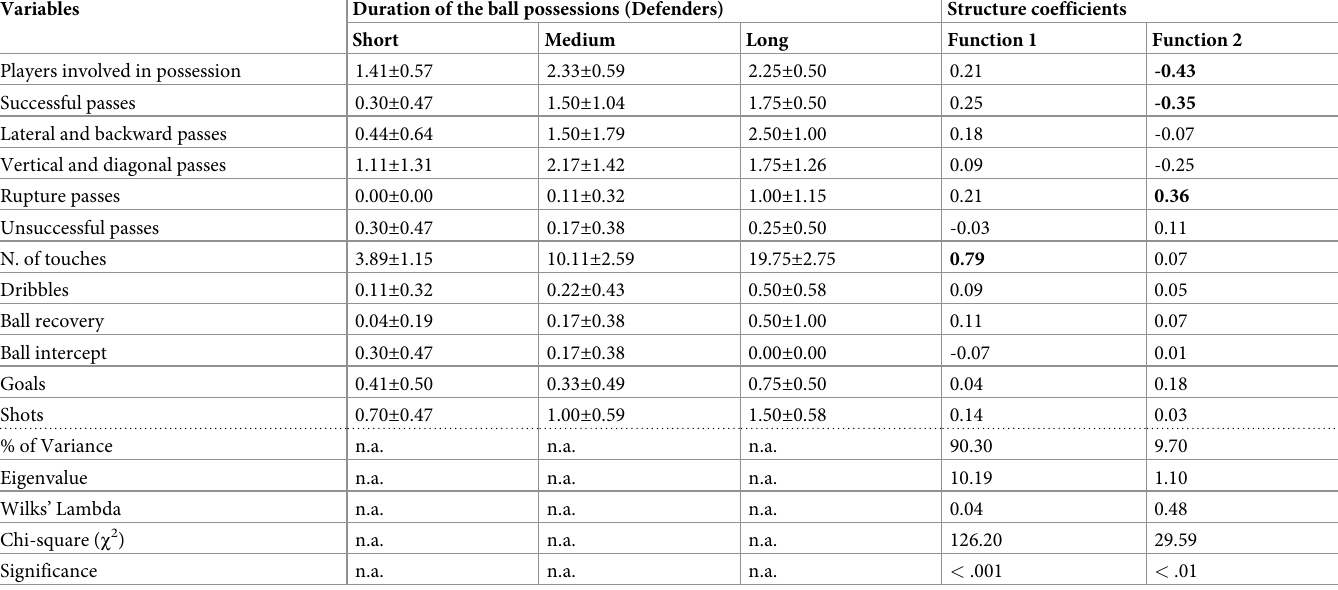
Table 2. Means ( ± SD), discriminant function details and structure coefficients for the three clusters according to the defenders game